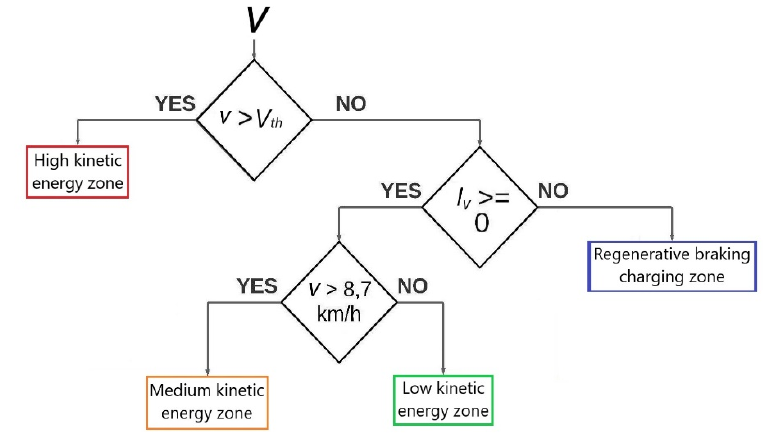
Figure 10. Control algorithm flow diagram.